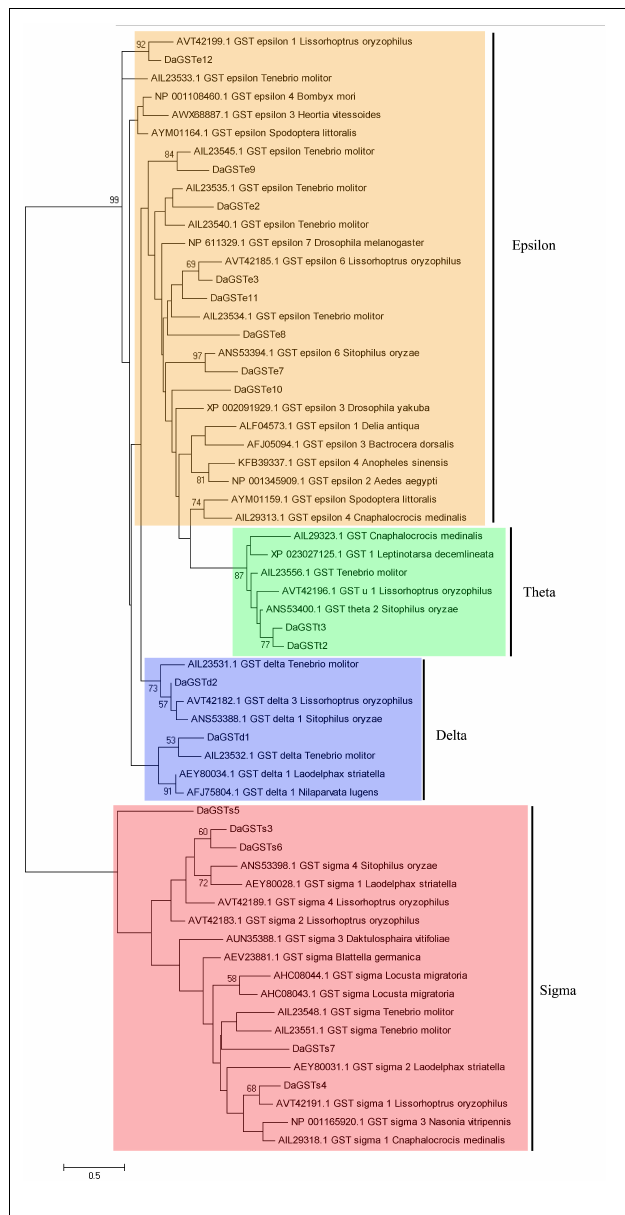
FIGURE 1 | Phylogenetic analysis of sequences of GST genes from Dendroctonus armandi was performed using the amino acid substitution model WAG+ G (–ln L = 5008.27, G = 2.7011). The matched genes are listed by the accession numbers of the corresponding sequence in GenBank. Bootstrap values after 500 pseudoreplicates are shown as nodes. The evolutionary branch is divided into four parts: epsilon is orange, theta is green, delta is blue, and sigma is